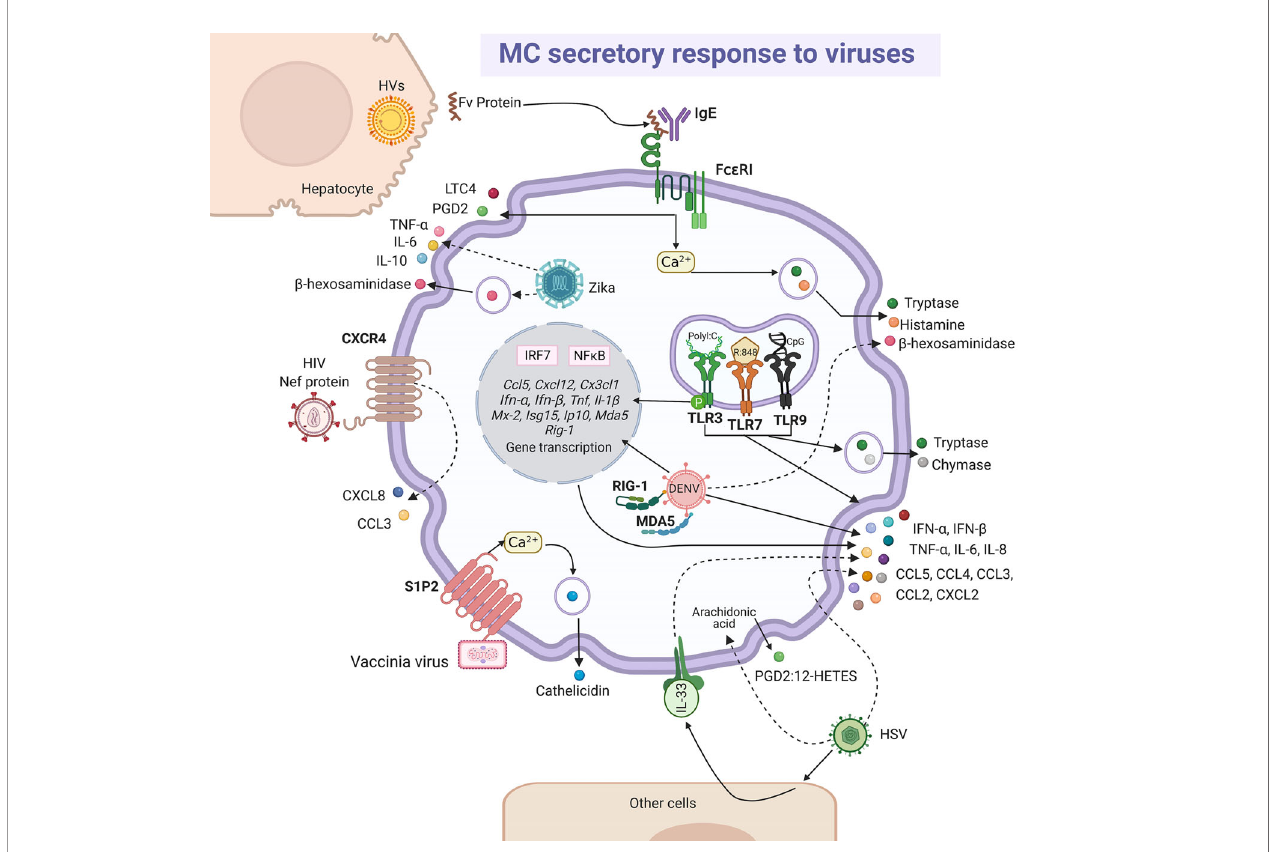
FIGURE 5 | MC-released mediators and signaling pathways in response to viruses. Some viral particles are recognized directly by membrane receptors, i.e. vaccinia virus binds sphingosine-1-phosphate 2 (S1P2) receptor and human immunode fi ciency virus (HIV) to CXCR4, triggering signaling pathways leading to cathelicidin or CXCL8 and CCL3 chemokines release, respectively. Intracellular dengue virus (DENV) is probably recognized by RIG-1 and MDA5 and herpes simplex virus (HSV) directly or through the release of alarmin IL-33 by other cells lead to the secretion of cytokines and chemokines, together with the arachidonic acid derivatives prostaglandin 2 (PGD2) and 12-hydroxyeicosatetranoic acid (12-HETES). Fv endogen superantigen from hepatocytes infected by hepatitis viruses (HVs) promotes MC degranulation and the release of leukotriene C4 (LTC4) and prostaglandin D2 (PGD2) by a mechanism that seems to depend on the activation of Fc ϵ RI receptor and calcium mobilization. Zika virus infection promotes MC degranulation and cytokine secretion. Finally, classical responses to viral compounds via TLR3, TLR7 and TLR9 receptors have been observed in MCs, that lead to the synthesis of interferon (IFN)- a and IFN- b through the activation of interferon regulatory factor (IRF)-7 and NF k B, and also to the release of tryptase and chymase. Solid-lines indicate known pathways and dashed-lines show reported effects of receptor triggering or MC-virus interactions, although speci fi c signaling cascades remain to be